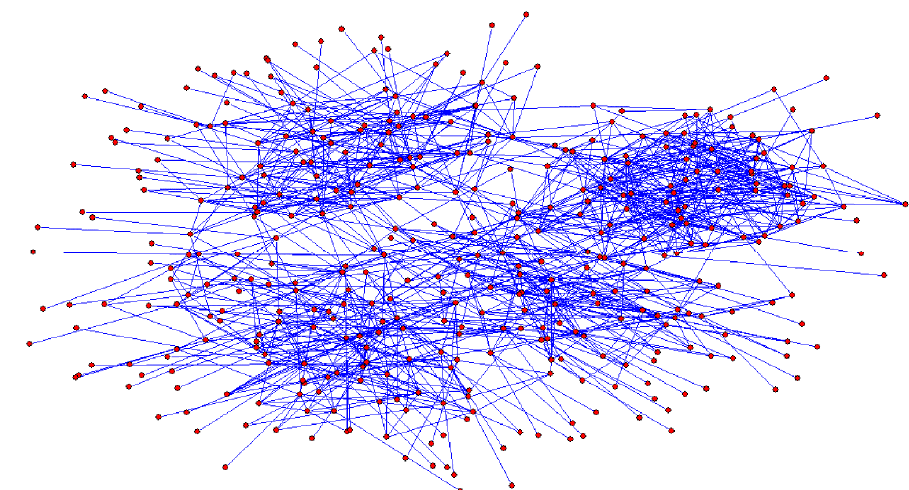
Figure 1. Social network of herdsmen in Menyuan County. Each node represents a herder and each linkage between two nodes represents a relationship between two herders.